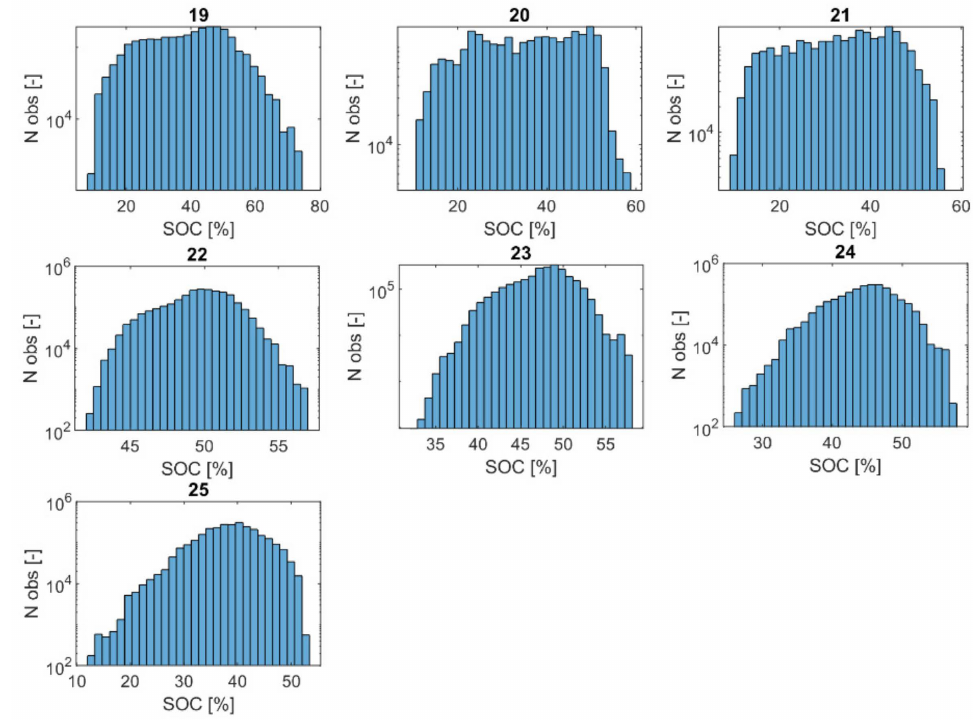
Figure 18. The SOC distribution (cases